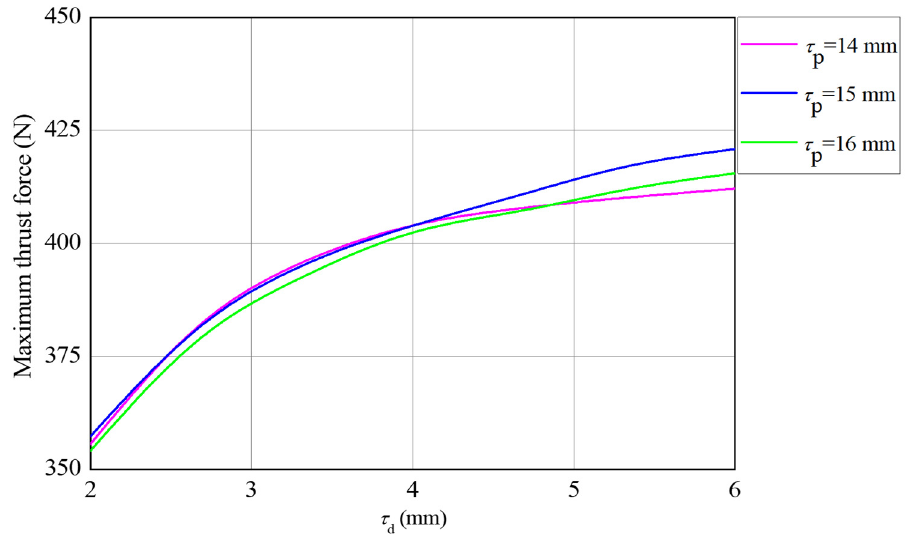
Figure 7. Variation in the maximum thrust force with thickness of the pole-shoe τ d